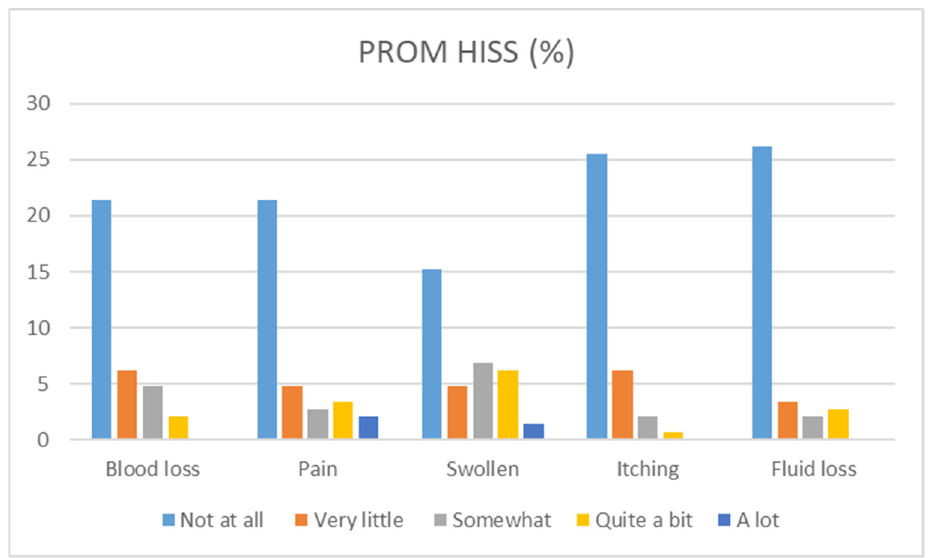
Figure 3. Overview of the responses on the Patient-Reported Outcome Measure-Haemorrhoidal Impact and Satisfaction Score (PROM-HISS). Table 3. Overview of responses on the PROM-HISS, n (%) (PROM-HISS = patient-reported haem-